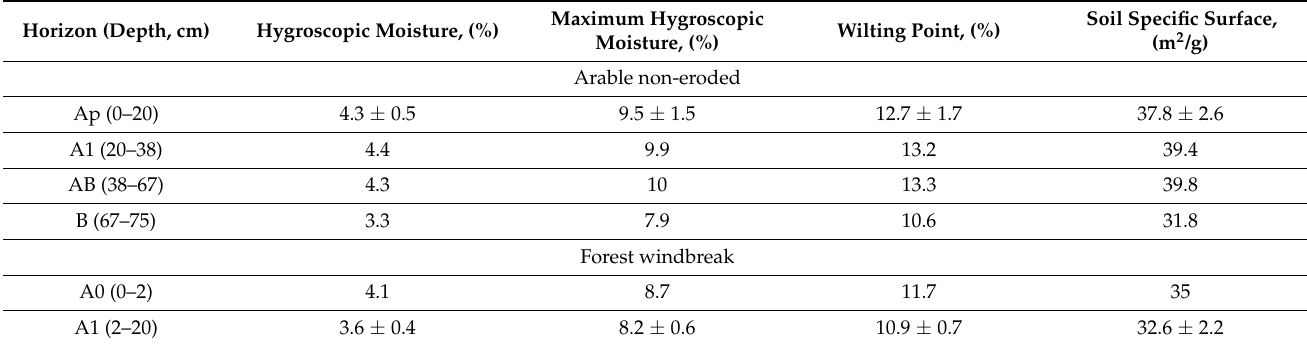
Table 4. Water-physical properties of the study soils (mean + SD).